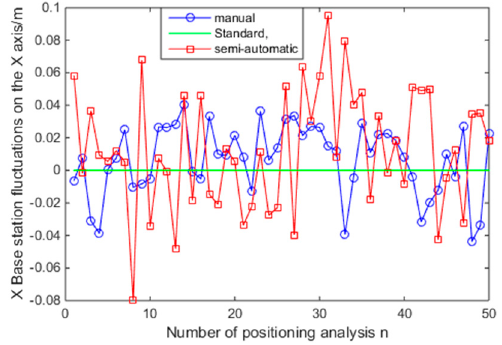
Figure 17. Target positioning error on x axis.